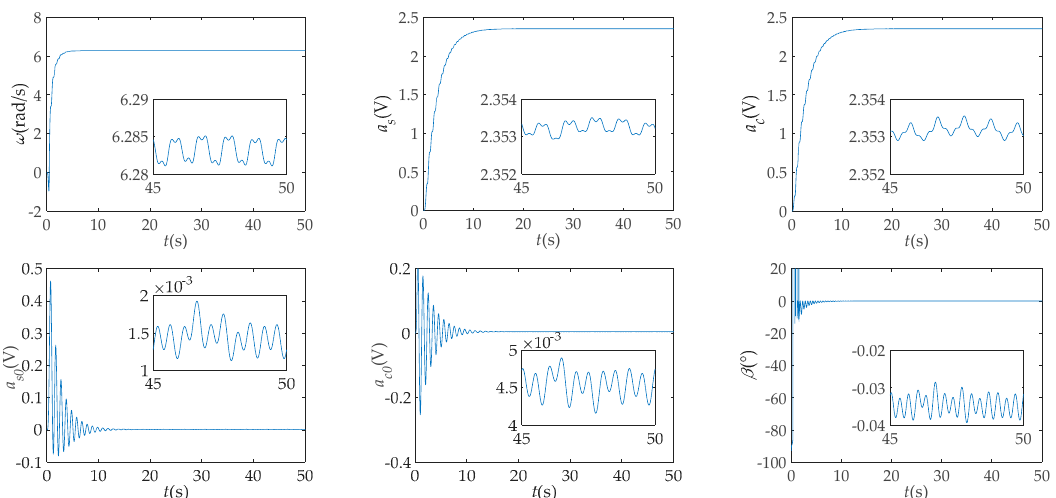
Figure 15. Estimations of angular velocity and imperfect parameters after the Butterworth filter (Group 2).